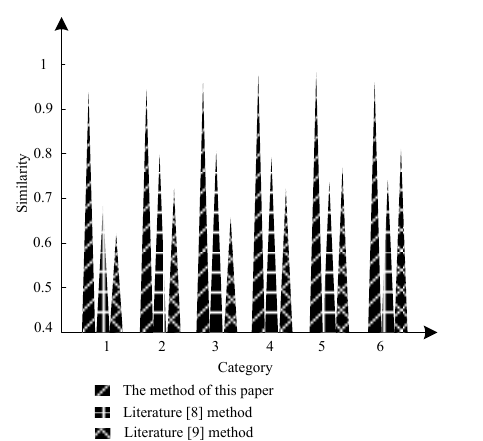
Figure 7. Image mining similarity results of the same